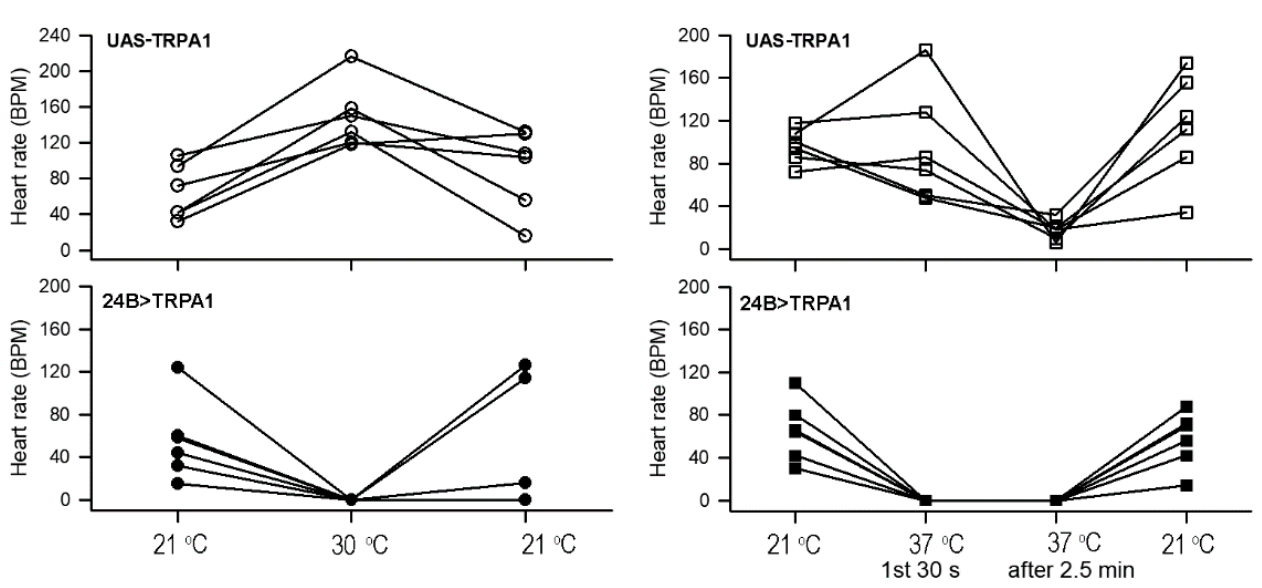
Figure 4. The heart rate for the dissected larvae over expressing TrpA1 in all mesoderm tissue. The UAS-TrpA1 line from 21 to 30 °C (upper left; p < 0.05, paired t -test). The same strain showed variation upon exposure at 37 °C, with some larvae increasing in rate and others decreasing. After 2.5 min, the rates decreased, but upon exposure to 21 °C, the rates increased (upper right). The 24B>TrpA1 animals’ hearts rapidly stopped beating at 30 °C (lower left) and 37 °C (lower right). The rates would increase upon exposure back to 21 °C. These strains were all raised at 21 °C.